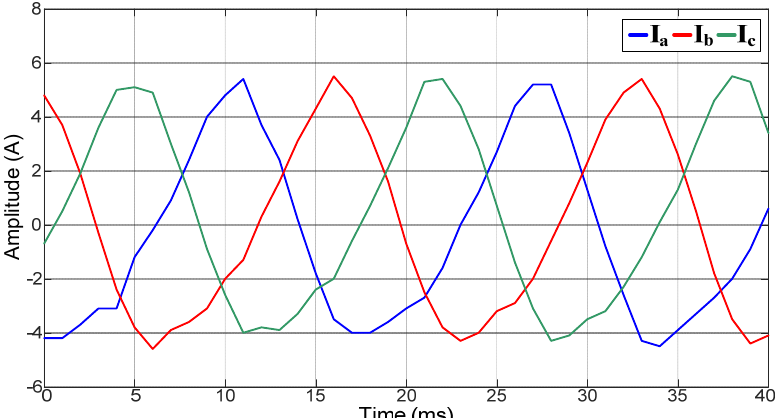
Figure 7. Phase currents from an induction motor in healthy condition.